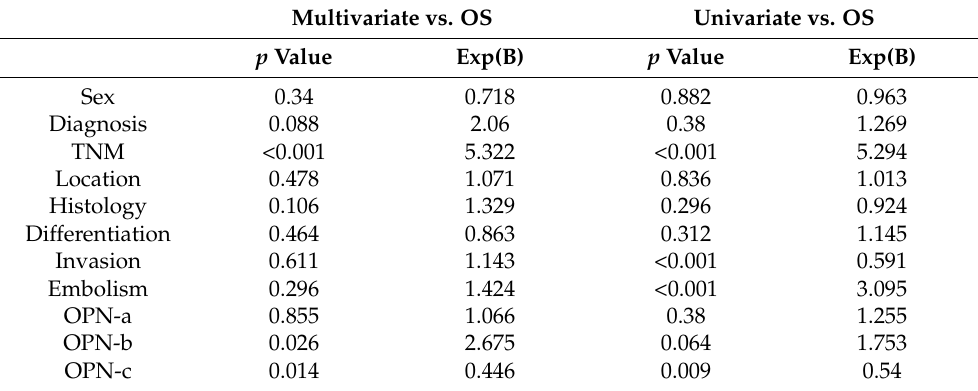
Table 3. Multivariate and univariate analysis of overall survival (OS). Exp(B), exponentiation of